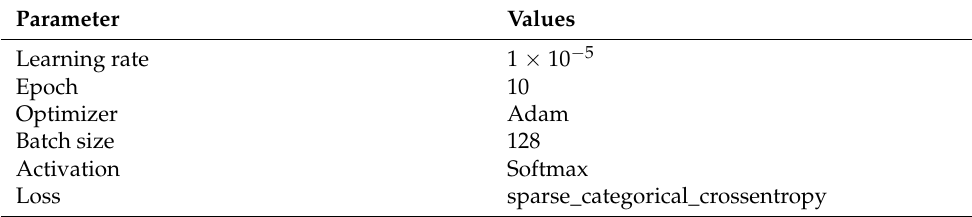
Table 7. Parameter setting for BERT with CNN, RNN, and